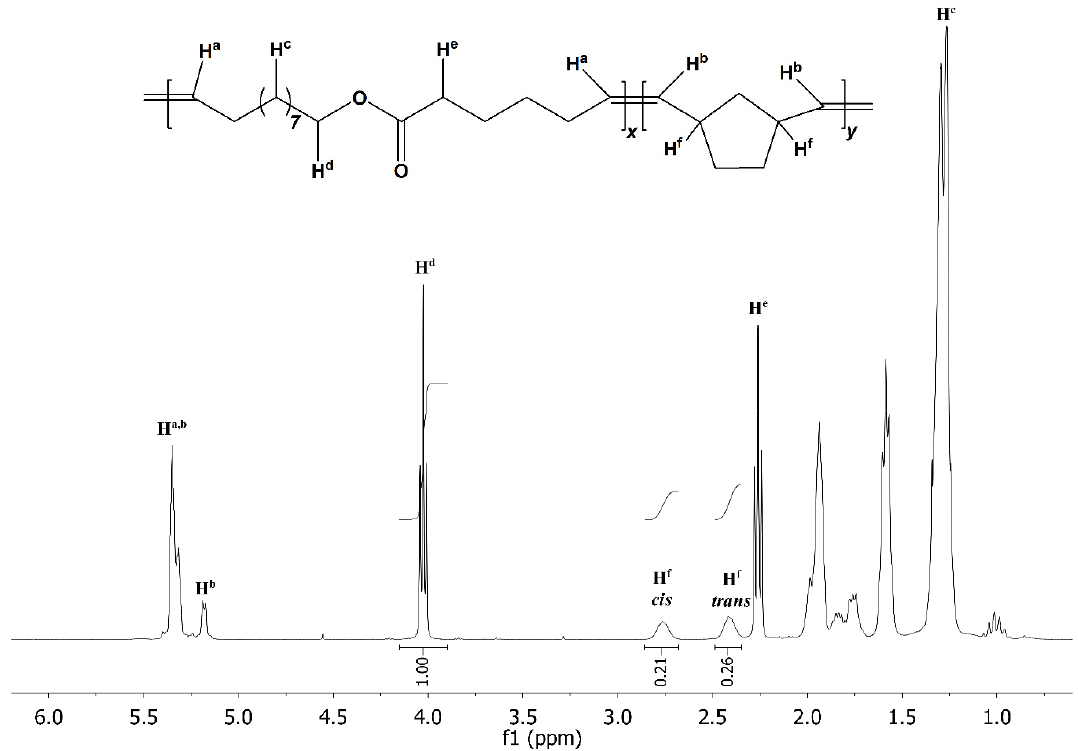
Figure 1. 1 H-NMR (400 MHz, CDCl 3 ) spectrum of the copolymer HDL-NB (Table 1, entry 12 ). The copolymerization of HDL-NB was studied as a function of time. Copolymerization was synthesized using a molar ratio [HDL]/[NB] = 1 at 50 ◦ C with Ru1 catalyst (Table 1, entries 3–7). The HDL incorporation percentage in PNB was determined by 1 H-NMR. We can see from Table 1 that during copolymerization, NB monomer was polymerized faster than HDL due to its high cyclic strain. HDL incorporation in NB was 39–42% over the period from 4 to 30 min ( entries 3 and 4 ). In this time, the molecular weight of the copolymer was increased four orders of magnitude M n × 10 4 g mol − 1 . After 3 h, the HDL incorporation in NB was increased until the copolymerization reached equilibrium HDL-NB with a molecular weight M n × 10 5 g mol − 1 ( entry 7 ). On the other hand, the copolymerizations of HDL and NB via ROMP, for reactivity constants determination, were carried out at 50 ◦ C and 80 ◦ C using Ru1–Ru3 catalysts (Scheme 1). For each catalyst, the reactions were conducted at 50, 60, 67, 75, and 91 mol percentage of HDL in the feed and polymerized up to a conversion of max. 22.10 ( Ru1 ), 19.50 ( Ru2 ), and 15.70 ( Ru3 ) weight percentage, respectively (Table 2). The molar ratio of C=C monomer to Ru1 was 500. Since at the conversion desired monomer HDL was not detected in the copolymer formed when the reactions were conducted at a molar ratio of [C=C]/[ Ru2, Ru3 ] = 500, the experiments for reactivity constant determination were carried out at 250. The copolymer was separated from the residual monomer by precipitation, and the incorporation of HDL in the different copolymers synthesis was quantified by 1 H-NMR ( entries 1–15 ). Additionally, in Table 2 it can be seen that as the mol percentage of HDL in the feed increased for each catalyst, more reaction time was needed for copolymerization to take place until the conversion desired. The time required for incorporating HDL into the copolymer was relatively short when the catalyst Ru1 was used ( entries 1–5 ), while for the presence of the catalysts Ru2 and Ru3 , long periods from 2 to 7 h were required ( entries 6–15